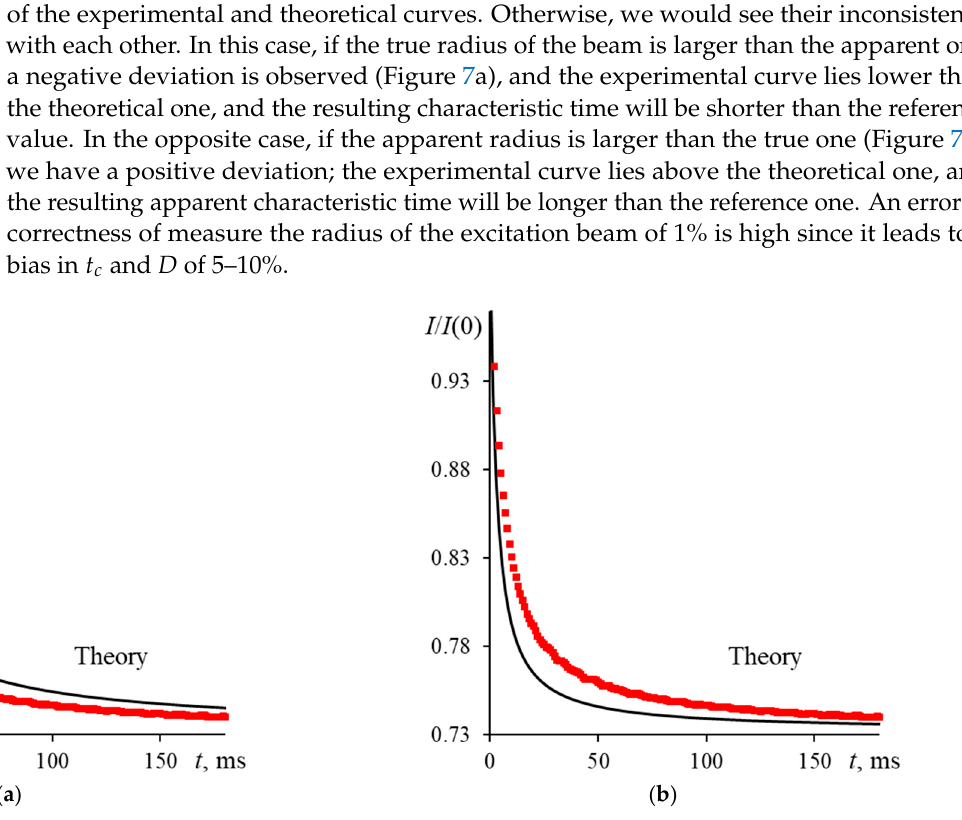
Figure 7. Normalized transient curves for an aqueous solution of ferroin (2.5 µmol/L) with incorrect measurement of the beam radius in the sample, where: ( a ) is the true radius of the excitation beam is less than the measured one; ( b ) is the true radius of the excitation beam is larger than the measured one; narrow-focused configuration ( 𝜔 (cid:3032)(cid:2868) = 33 µm, Figure 1, Table 3).